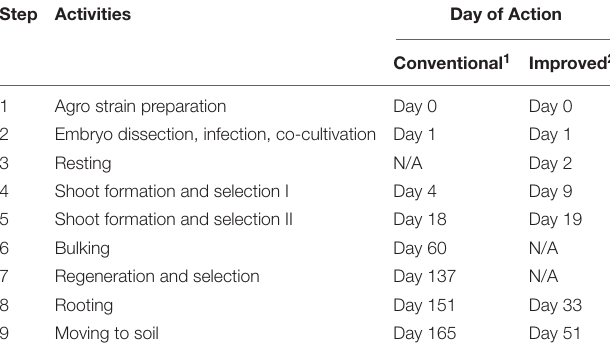
TABLE 4 | Comparison of conventional and improved B104 transformation